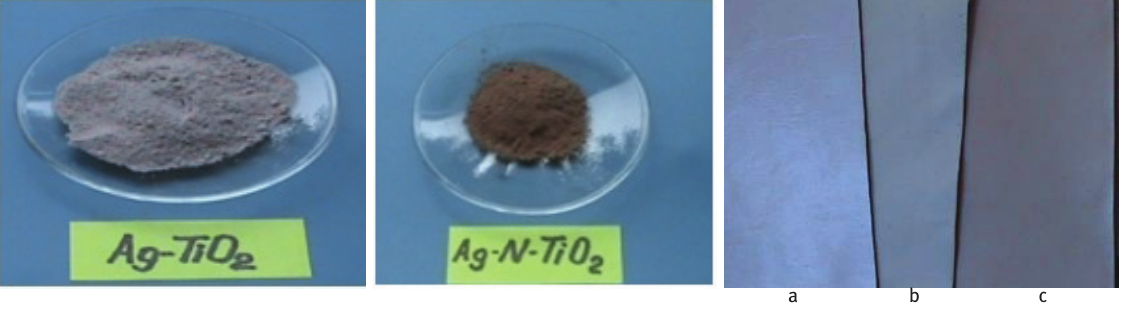
NPs and Ag-N-TiO Figure 1: Ag-TiO 2